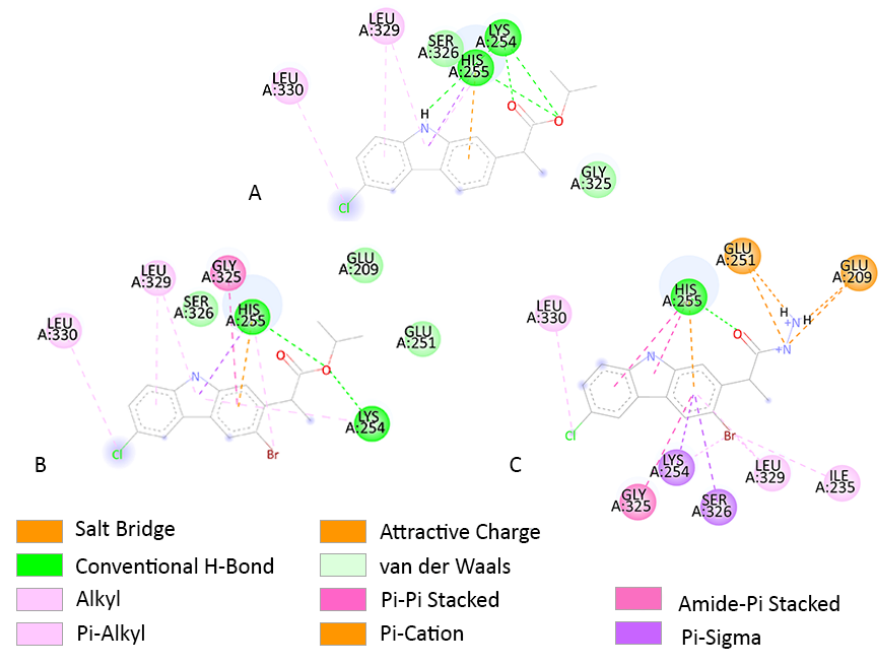
Figure 14. Predicted interactions between compounds 4 ( A ), 7 ( B ), and 10 ( C ) in interaction with FtsA. Images were obtained using Discovery Studio Visualizer [33].